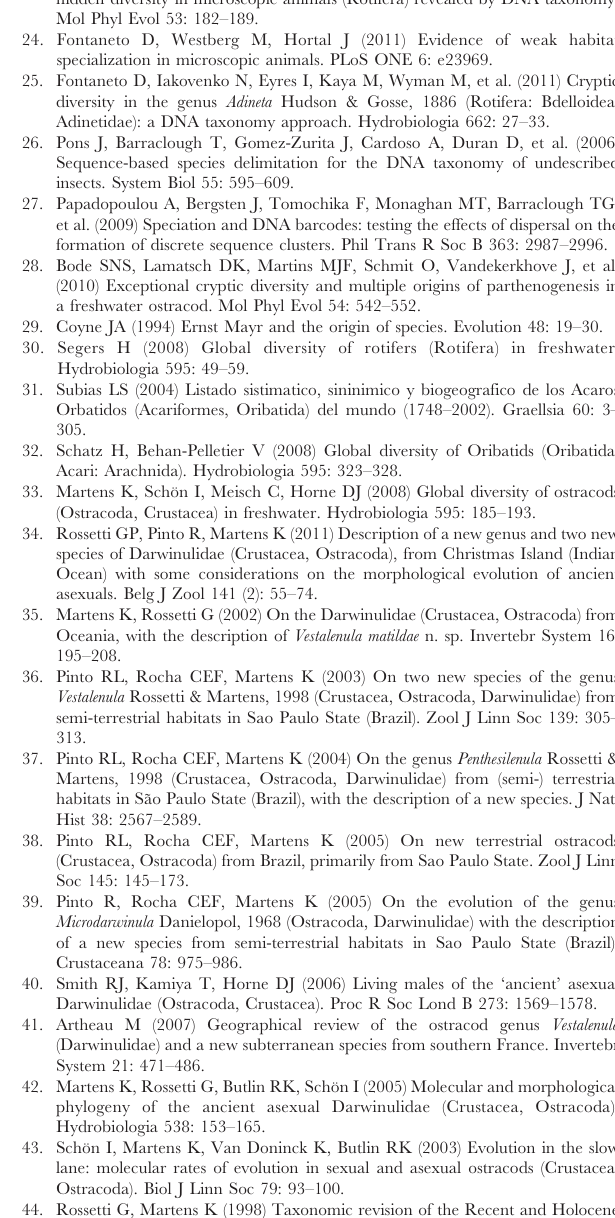
Table S2 Overview of specimens analysed for